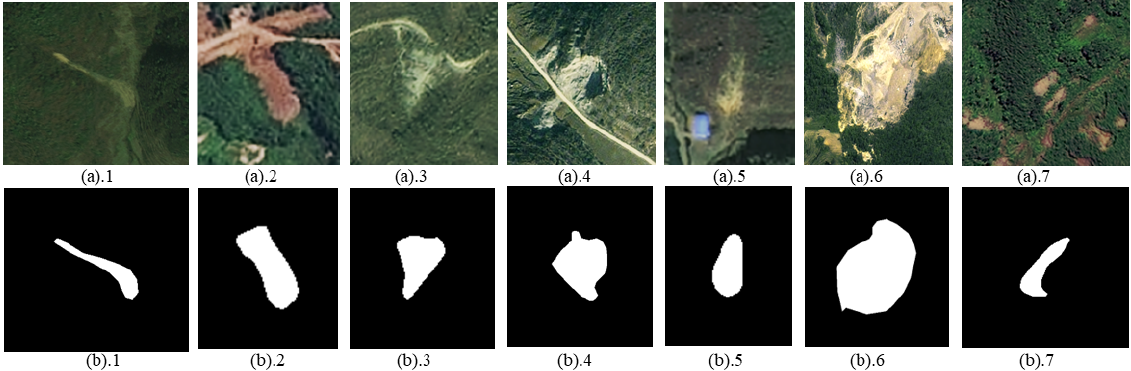
Figure 8. Examples of landslide patches in the Bijie landslide dataset. ( a ).* RGB images of each land- slide inventory. ( b ).* Manually delineated landslide mask.